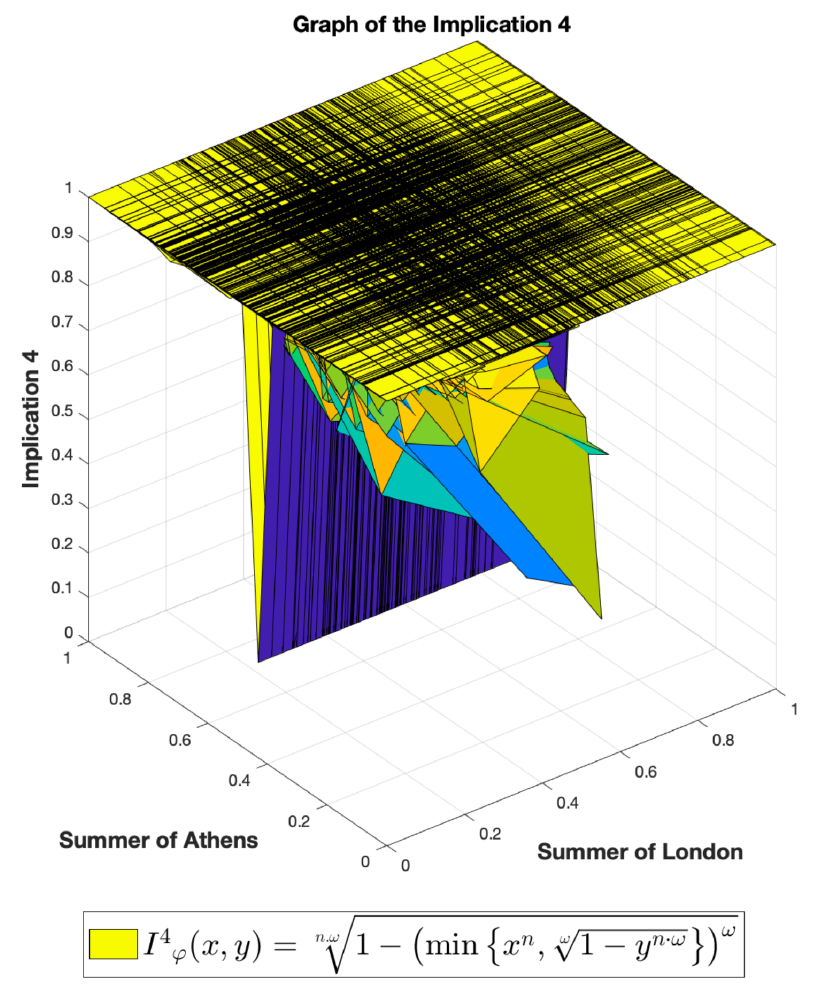
Figure 5. Graph of the Implication